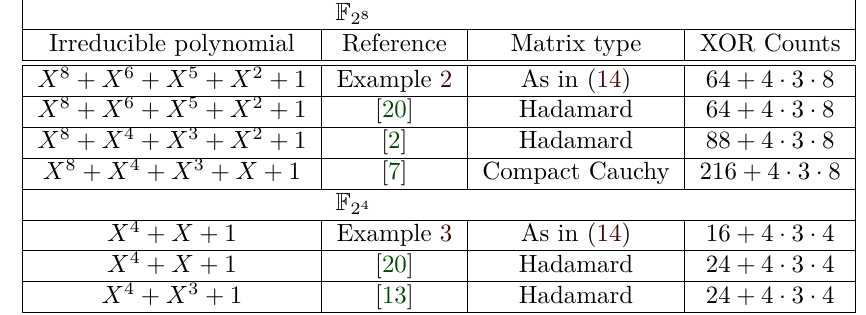
Table 2: Comparison of the XOR counts of 4 × 4 involutory MDS matrices over F F 2 4